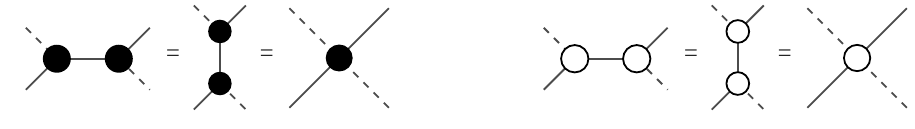
Figure 6 . De(cid:12)nition of BCFW bridge decoration in N = 8 SUGRA.